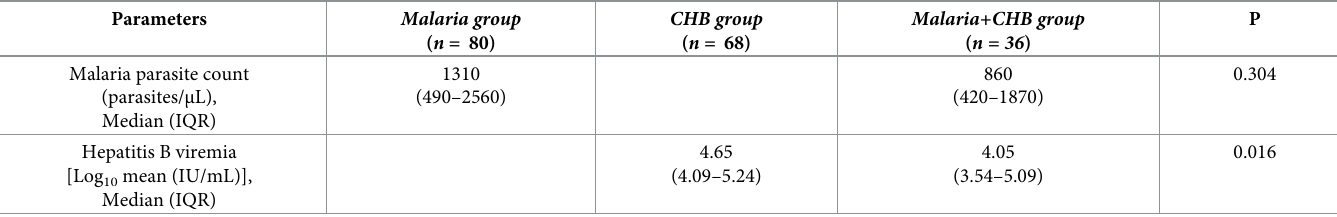
Table 2. Differences in malaria parasitemia and hepatitis B viremia amongst the different categories of pregnant women.